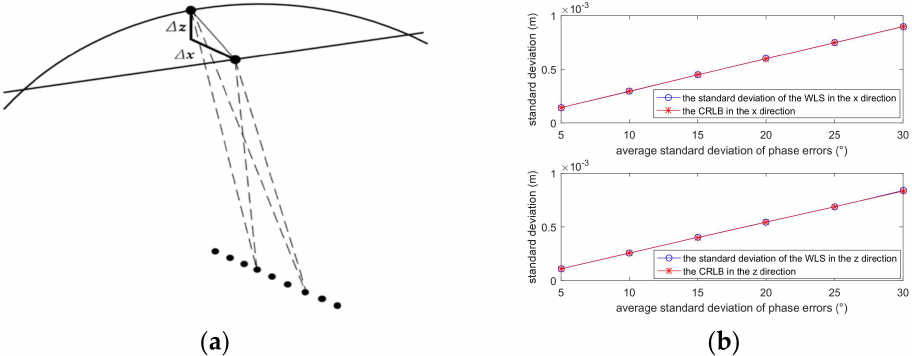
Figure 3. ( a ) Schematic diagram of verification experiment; ( b ) The verification results of the CRLB. Table 1. Incident angles and real phase errors of verification